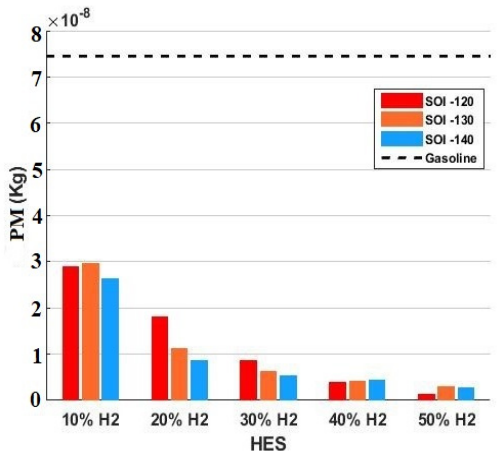
Figure 14. Effects of direct hydrogen injection timing and HES on particulate matter (PM) emissions. The contour of the changes for CO, NO X and PM emissions with an increase in HES at EVO and SOI − 120 aTDC are shown in Figure 15. As can be seen, with an increase in the percentage of hydrogen, CO and PM emissions decreased, which indicates more complete and clean combustion, but the NO X increased due to the higher combustion temperature of hydrogen.